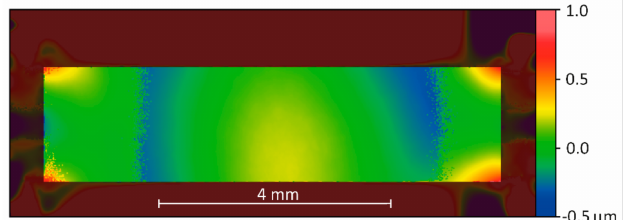
Figure 6. Surface deviation from an ideal parabolic cylinder surface for the deflected membrane shown in Figure 5a, membrane voltage 219